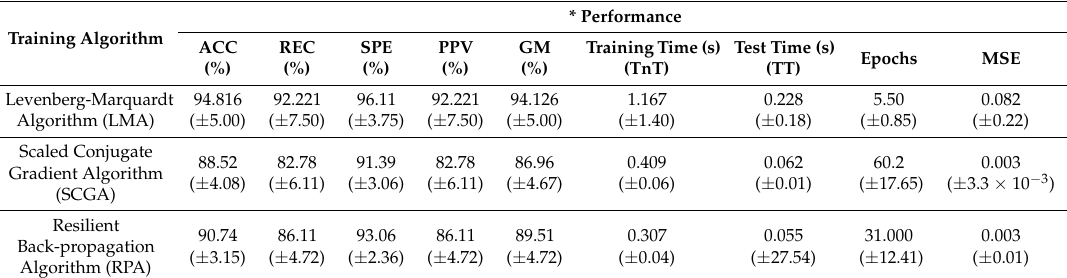
Table 8. Classification Performance